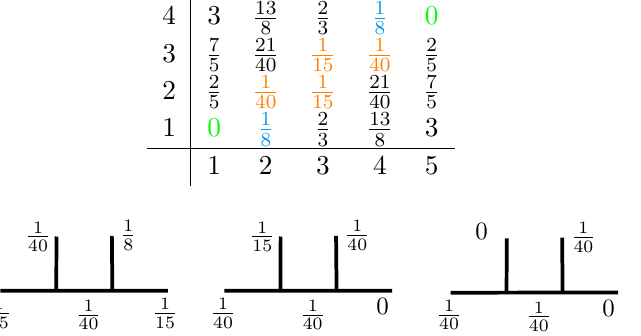
Figure 5. The CBs from Γ(3) (cyan) and Γ 0 (4) ∩ Γ(2) (green) in the tetracritical Ising model. The ones in orange appear for both of the dessins. The three CBs, from left to right, come from Γ(3) , (+ , + , − , − ) and ( − , + , − , +) in Γ (4) ∩ Γ(2) respectively. 0